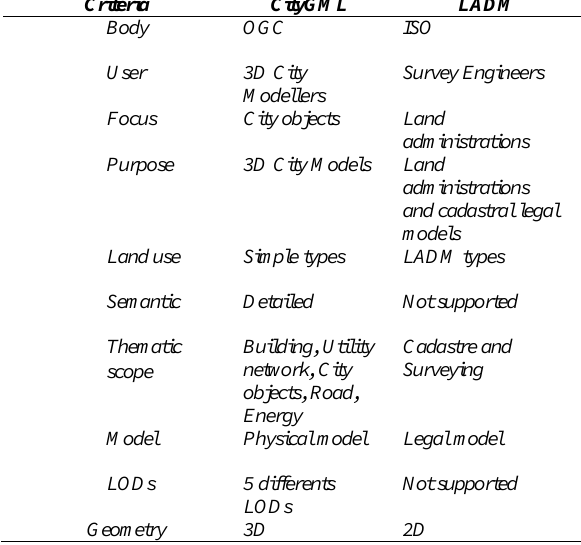
Table 3. Comparing CityGML with